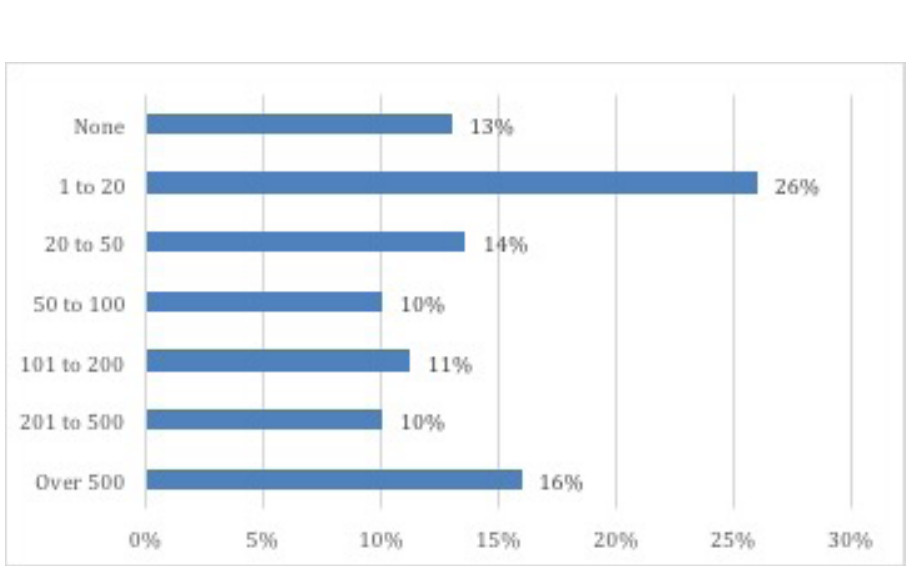
The survey also attempted to address the detectorists’ level of competence, through questions relating to the handling and the identification of find material. The clear majority stated that they hand over finds to museums together with detailed information and contextual data for each object; for example GPS coordinates (85.5%), a typological identification (64.8%), a unique ID (54.5%), a basic description (53.3%), a dating (29.7%) and even a report on the character of the find-spot and other possible archaeological observations (30.9%) (see fig.